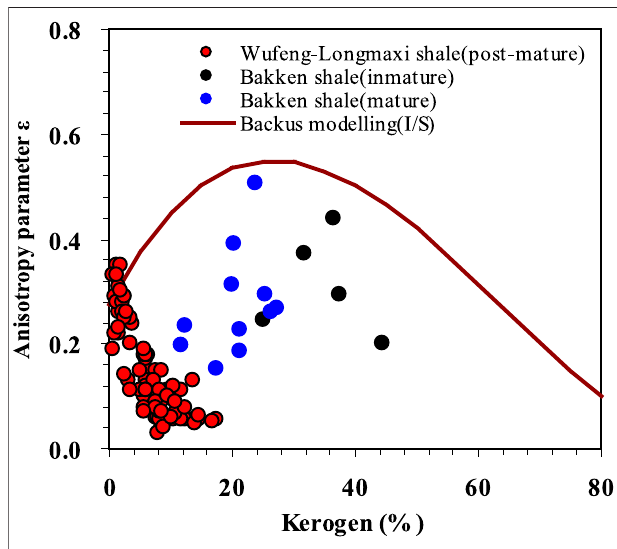
FIGURE7| Anisotropyparameter ε versuskerogen contentforWufeng- Longmaxi Formation shales and some mature and immature shales from Bakkenshalesdisplayedonthebackgroundofthemodi fi edBackusmodelfor two-layer illite/kerogen composite (Vernik and Nur, 1992).